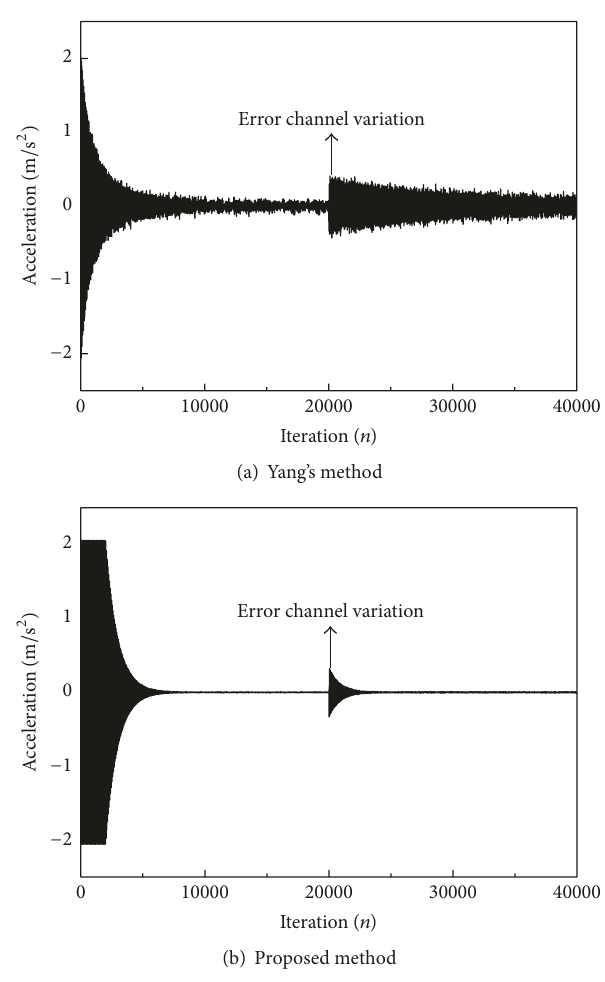
Figure12:PerformancecomparisonbetweenYang’smethodandthe proposed method with error channel